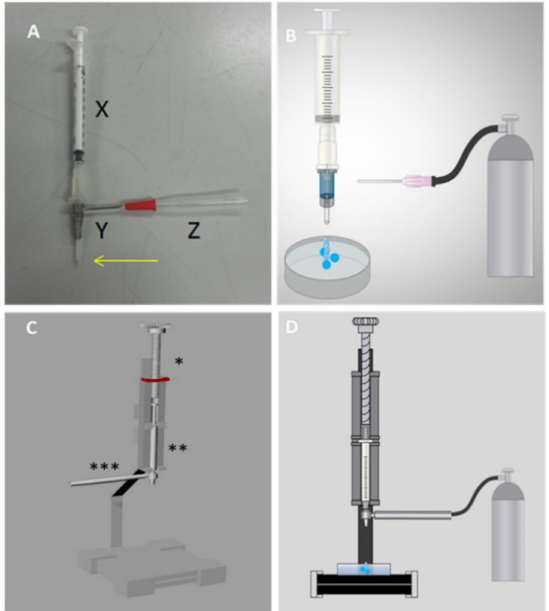
Figure 1. Prototype developed to carry out cellular encapsulation through a parallel air system. ( A ) First prototype produced with a long-stay peripheral venous puncture device (X = 1 mL syringe containing the sample in sodium alginate; Y = long-stay peripheral venous devices 16G on the outside and 24G on the inside; = needle connected to the nitrogen gas hose). The arrow highlights the end of the metallic needle 24G exposed to the environment; ( B ) first cellular encapsulation prototype coupled to the nitrogen gas bullet; ( C ) second complete prototype, prepared using a in 3D printer; * part that positions the syringe with the sample to be encapsulated; ** 1 mL syringe with sodium alginate solution; *** piece that connects to the parallel air system; ( D ) second cellular encapsulation prototype coupled to nitrogen